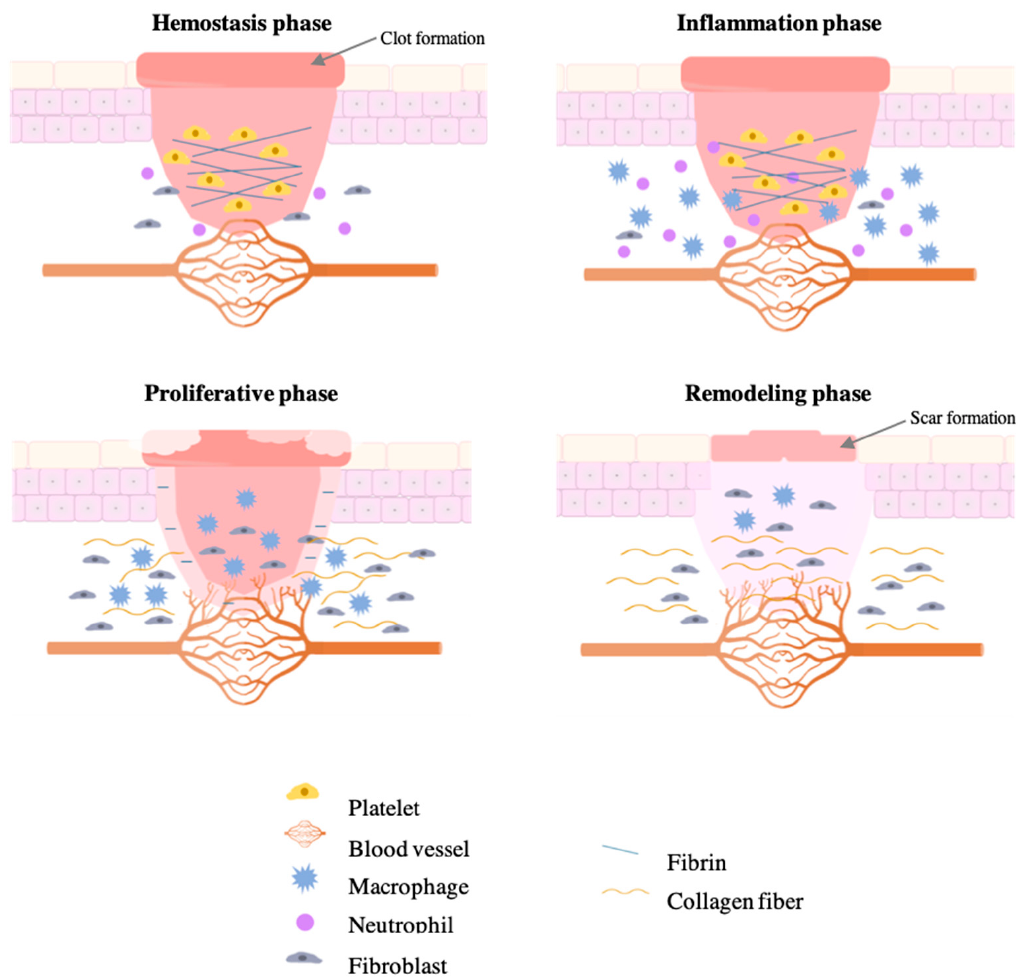
Figure 1. Different phases of normal wound healing.